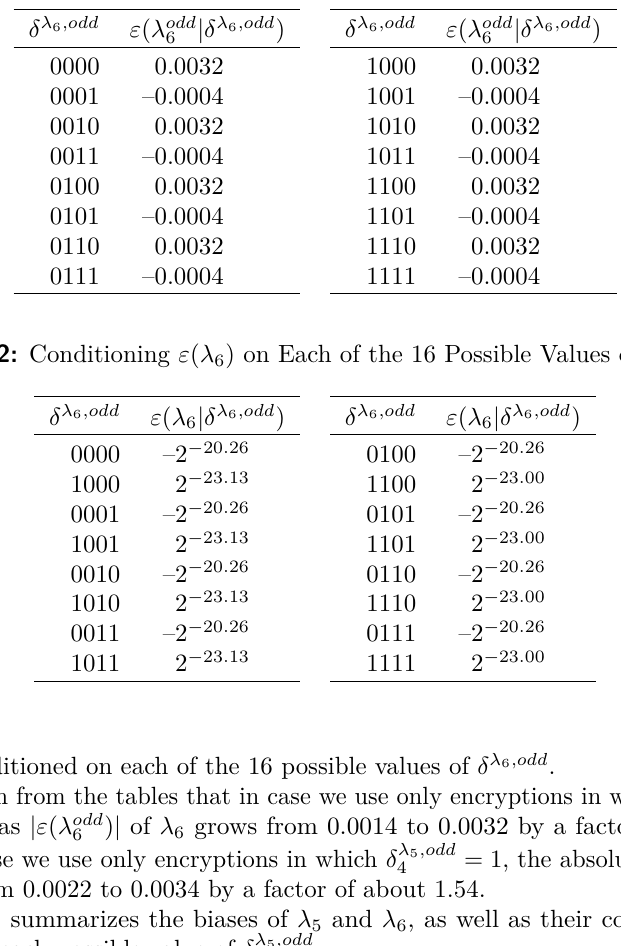
Table 11: Conditioning ε ( λ 6 odd ) on Each of the 16 Values of δ λ 6 ,odd